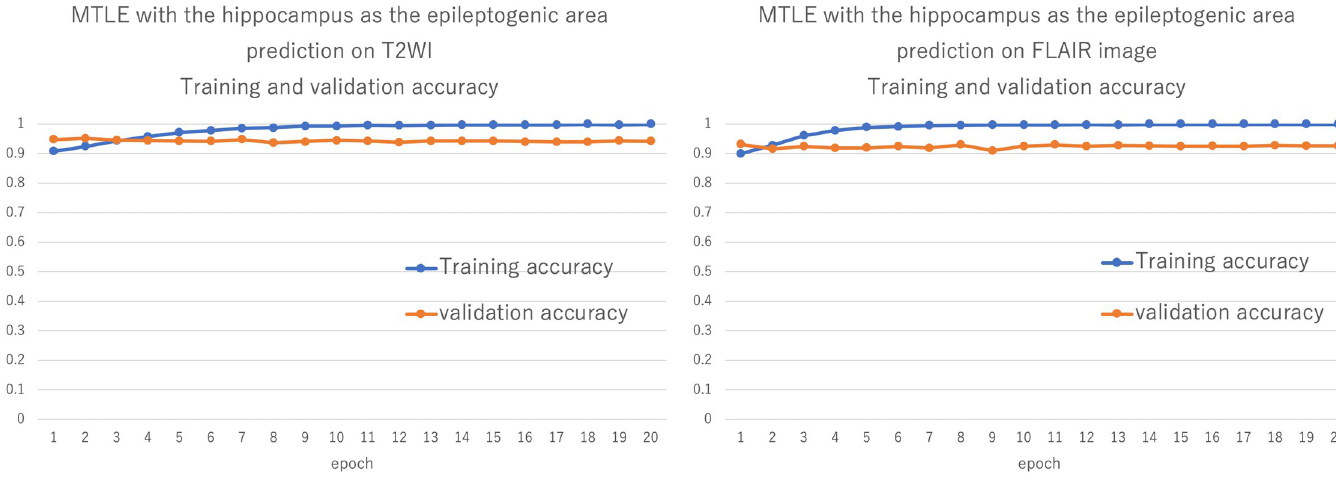
Fig 4. Validation of overall diagnostic accuracy. The diagnostic accuracy of the deep learning model for MTLE with the hippocampus as the epileptogenic area based on T2WI was 94.13% (left) and on FLAIR was 94.91% (right).